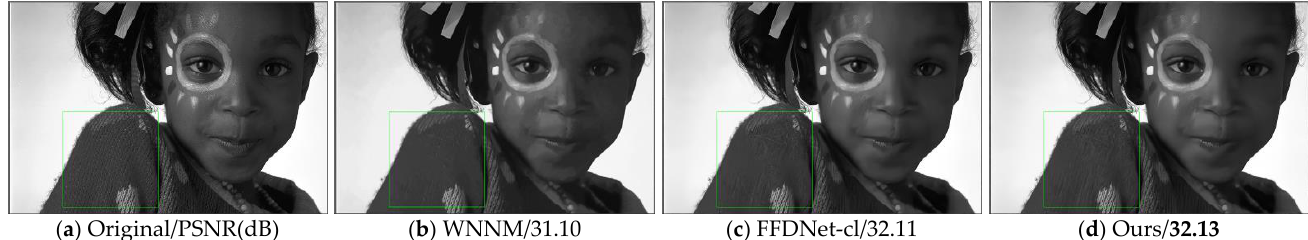
Figure 5. Image denoising results on kodim15 in Kodak24 with noise level σ n = 25. ( a ) The original image. ( b ) The result of WNNM. ( c ) The result of FFDNet-cl. ( d ) Our result. Table 4. The average PSNR values of test methods for denoising on the Bsd68 and Kodak24 datasets. Method